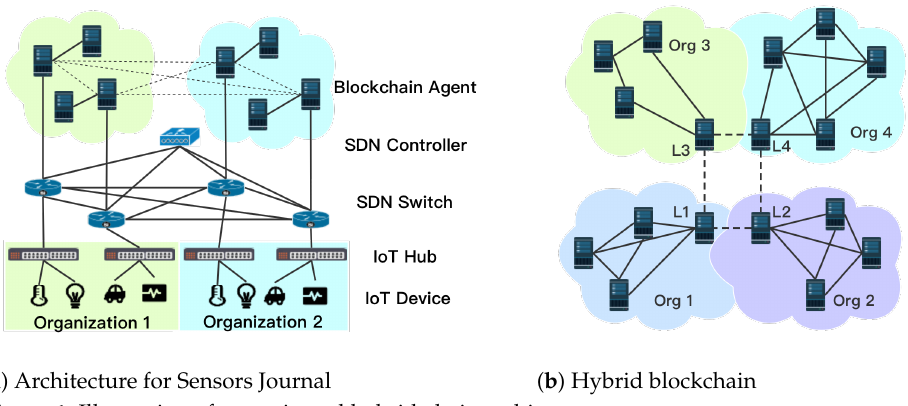
Figure 1. Illustration of scenario and hybrid-chain